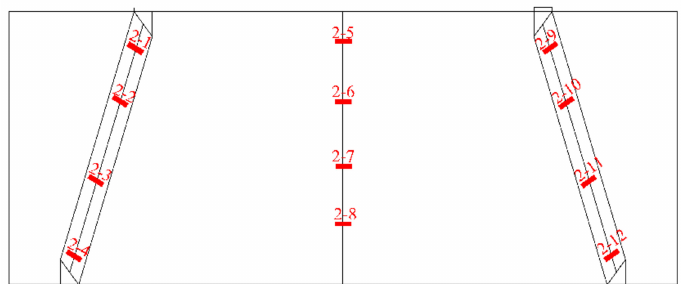
Figure 6. Arrangement of strain gauge of concrete.